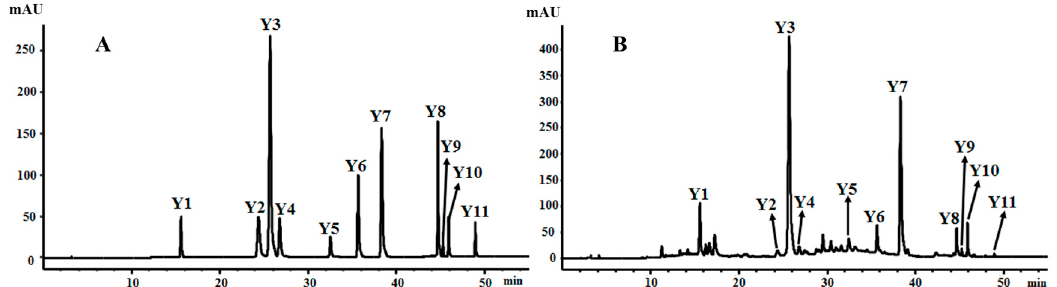
Figure 4. HPLCs of authentic standards and methanol extract of Buddleja officinalis flowers. ( A ) UV chromatogram of the 11 authentic standards at 330 nm; ( B ) UV chromatogram of methanol extract at 330 nm. (1) echinacoside (Y 1 ); (2) luteolin-7- O -rutinoside (Y 2 ); (3) acteoside (Y 3 );